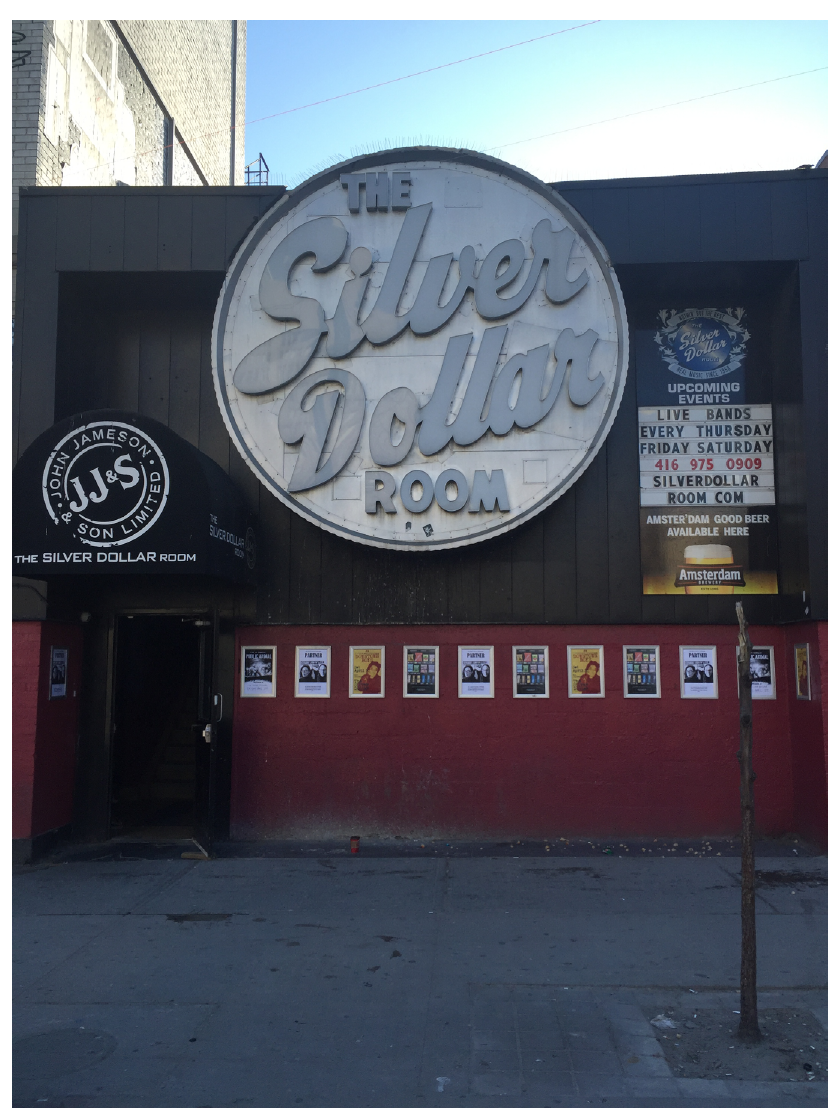
Figure 3. Exterior of the Silver Dollar Room, with its iconic